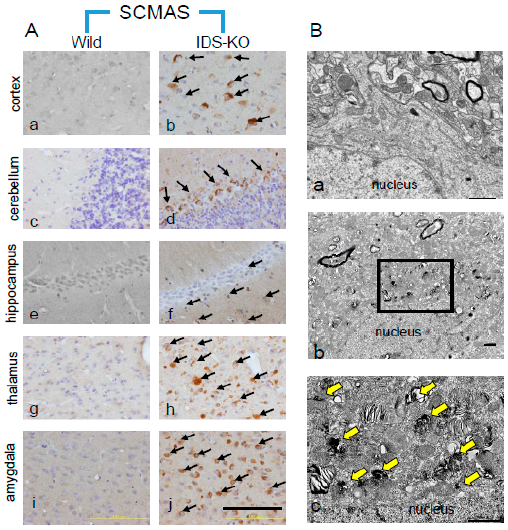
Figure 3. ( A ) Localization of SCMAS in the central nervous system (CNS) of wild-type and IDS-KO mice. No immunopositive cells were found in wild-type mice ( a , c , e , g , i ). In IDS-KO mice ( b , d , f , h , j ), immunopositive cells (arrows) were present in the cortex ( b ), cerebellum ( d ) hippocampus ( f ), thalamus ( h ), and amygdala ( j ). Bar = 100 µ m. ( B ) SCMAS immunoelectron microscopy of the cerebral cortical neurons of wild-type ( a ) and IDS-KO mice ( b , c ). The immune response was negative in the wild-type mouse ( a ). SCMAS immunopositivity was observed at the vacuoles with single membranes (arrows) and in mitochondria that were partially swollen ( b ). Immunopositive reactions were observed in layered finger-print-like arrays and multilayered array structures (( c ), arrows). Panel c shows the magnified view of an area indicated by a black rectangle in Panel b. Bar = 1 µ